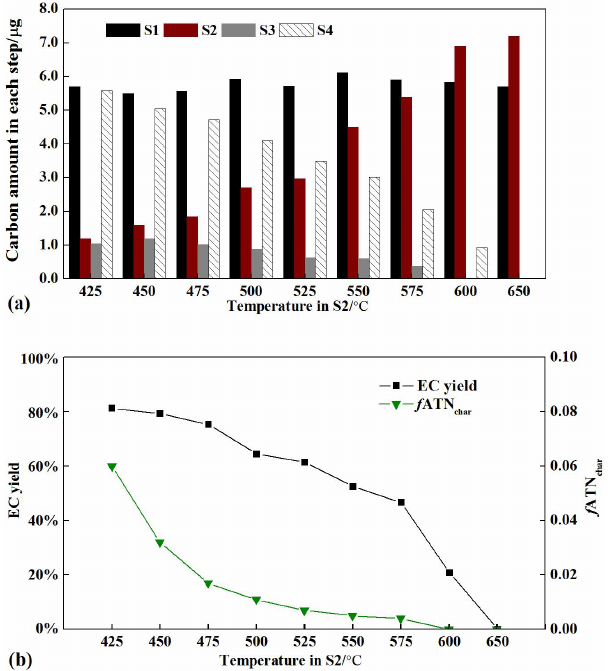
Fig. 5. Fig. 5. Carbon amounts released in each step (a) and f ATN char and EC yield in S4 (b) , as evaluated from analysing a typical water- extracted aerosol sample (ZUR1) by the Swiss 4S protocol with different S2